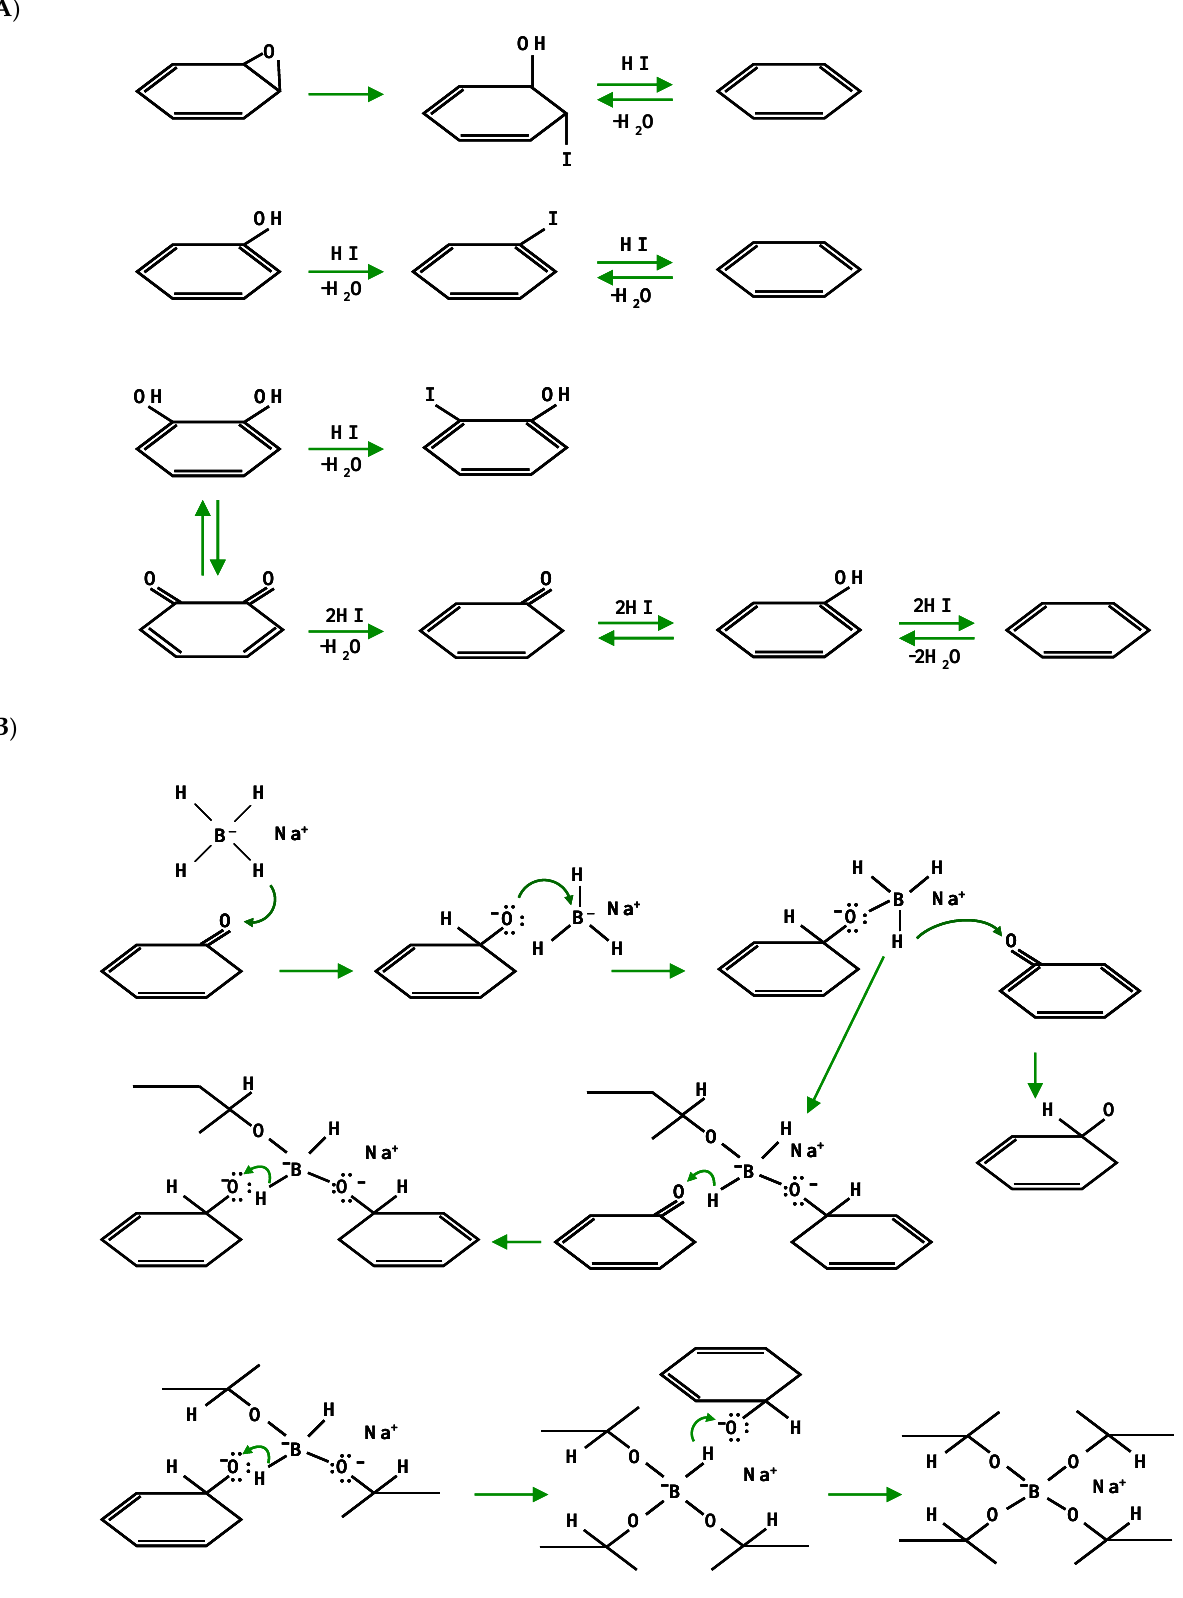
Figure 5. ( A ) Model of the chemical reaction occurring between oxygen-containing aromatic groups and HI; ( B ) progression of carbonyl group reduction until the complete depletion of B–H bonds and boron oxidation.